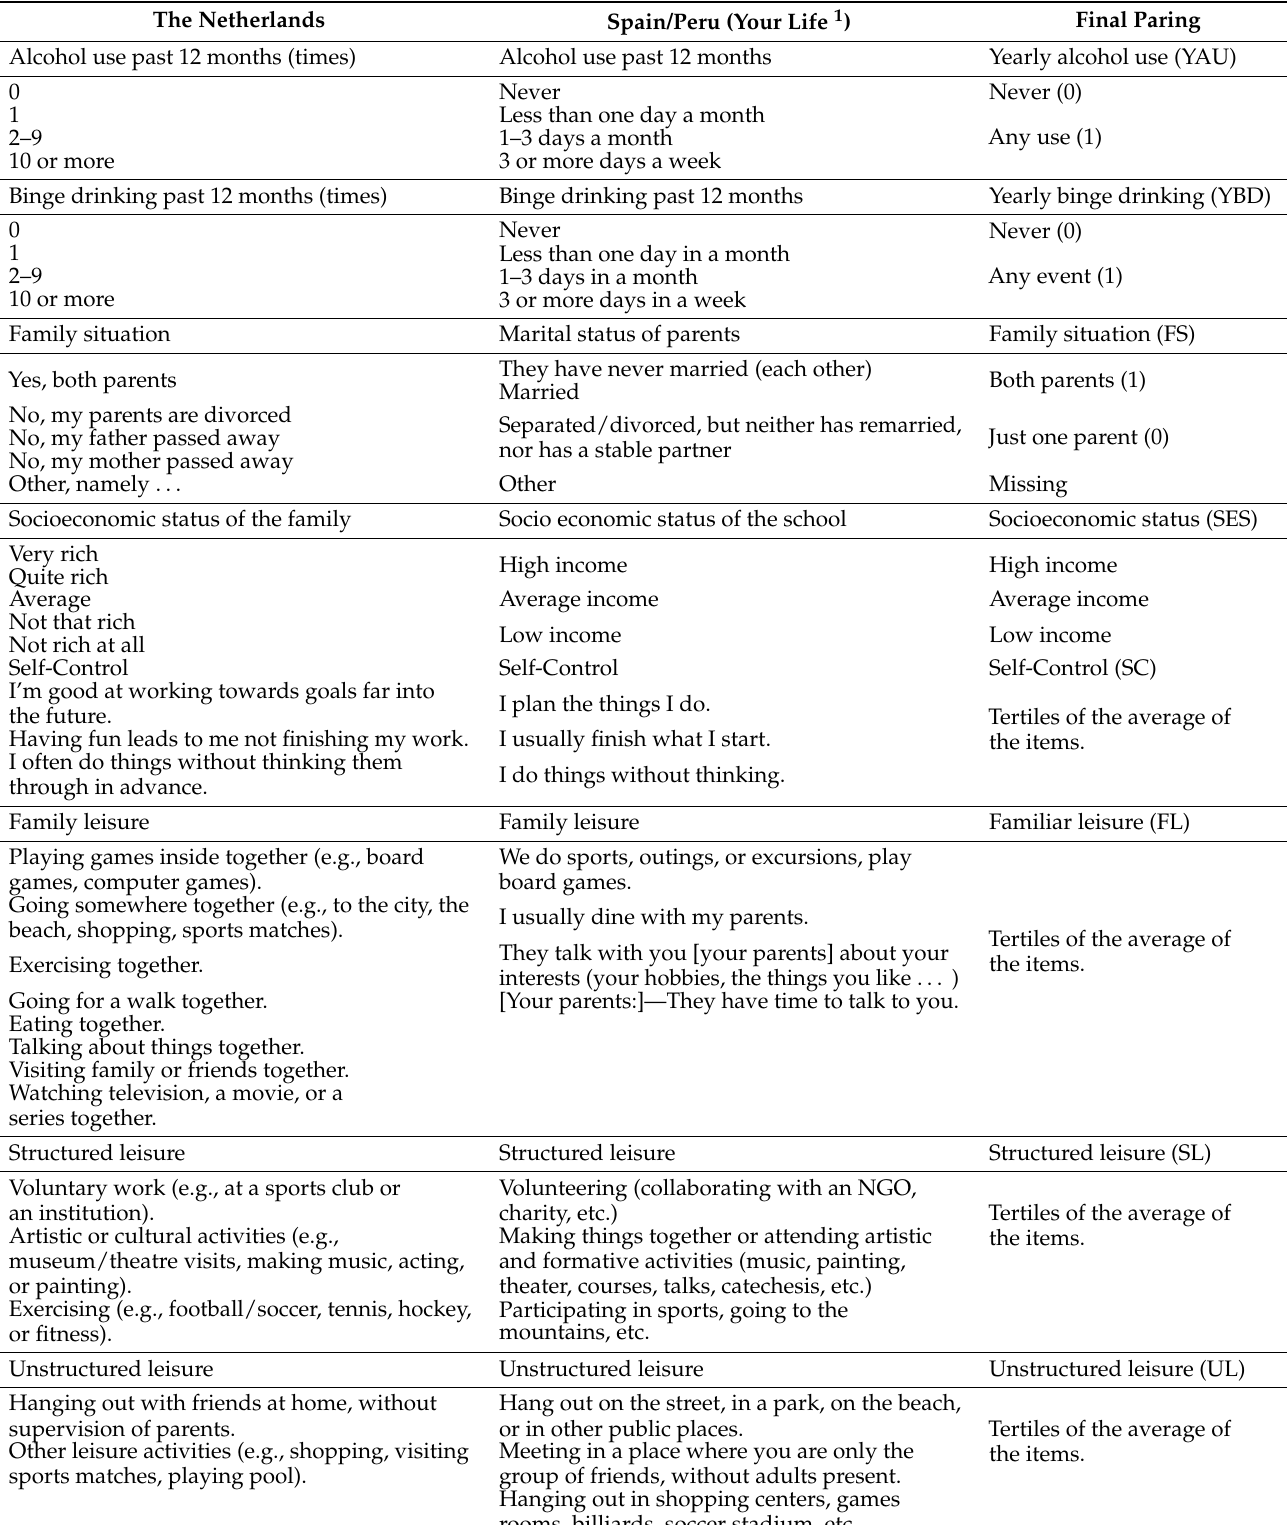
Table 1. Pairing by linguistic, semantic, and functional similarity for instruments of Your Life and Utrecht projects (questions and answer